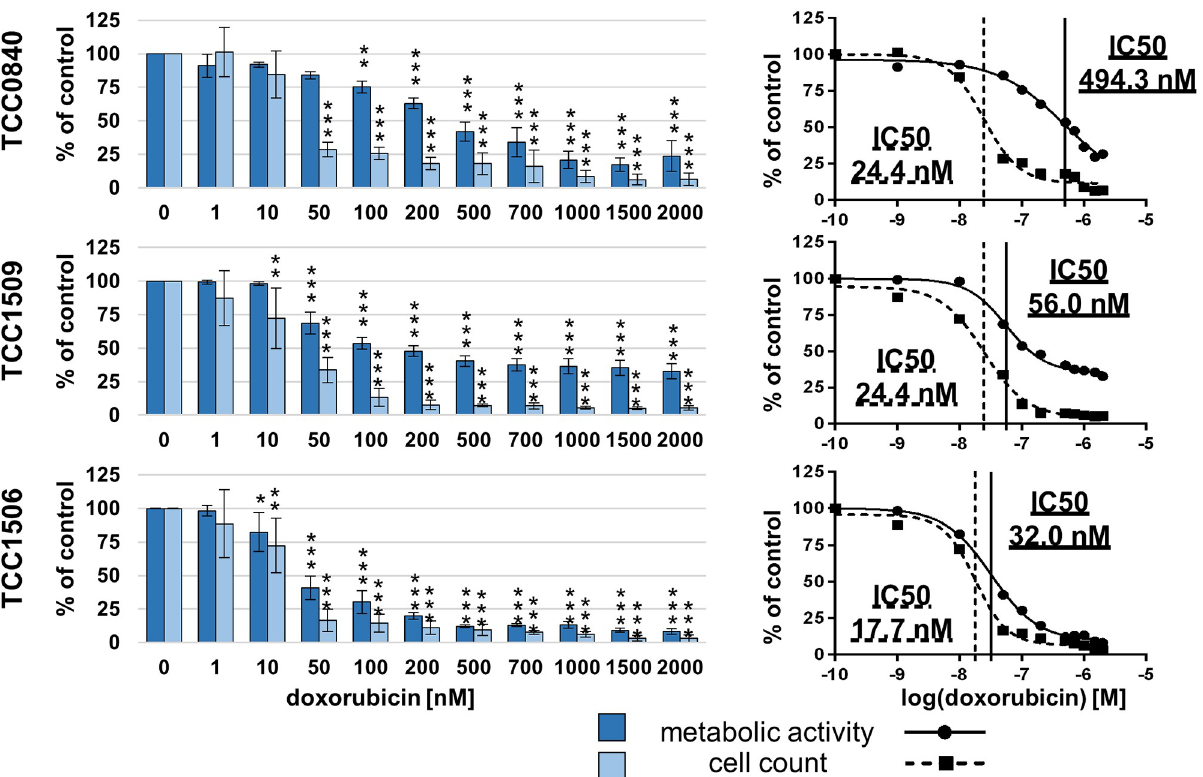
Fig 4. Metabolic activities and cell counts of TCC cell lines after 72 h incubation with doxorubicin. Means and standard deviation are displayed, n = 3 for metabolic activity, n = 4 for cell count, significances are referred to controls. � p < 0.05, p �� < 0.01 and p ��� < 0.01.